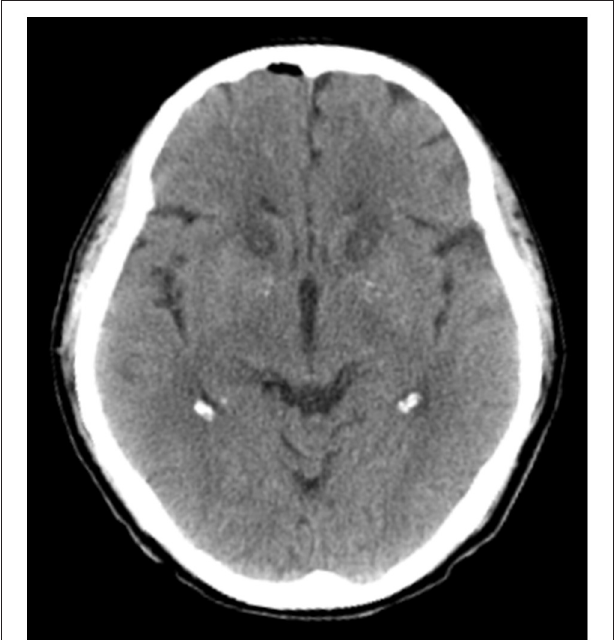
FIGURE 1 | A computed tomography slice of representative ALIC lesions created by bilateral anterior capsulotomy, taken on postoperative day 1.